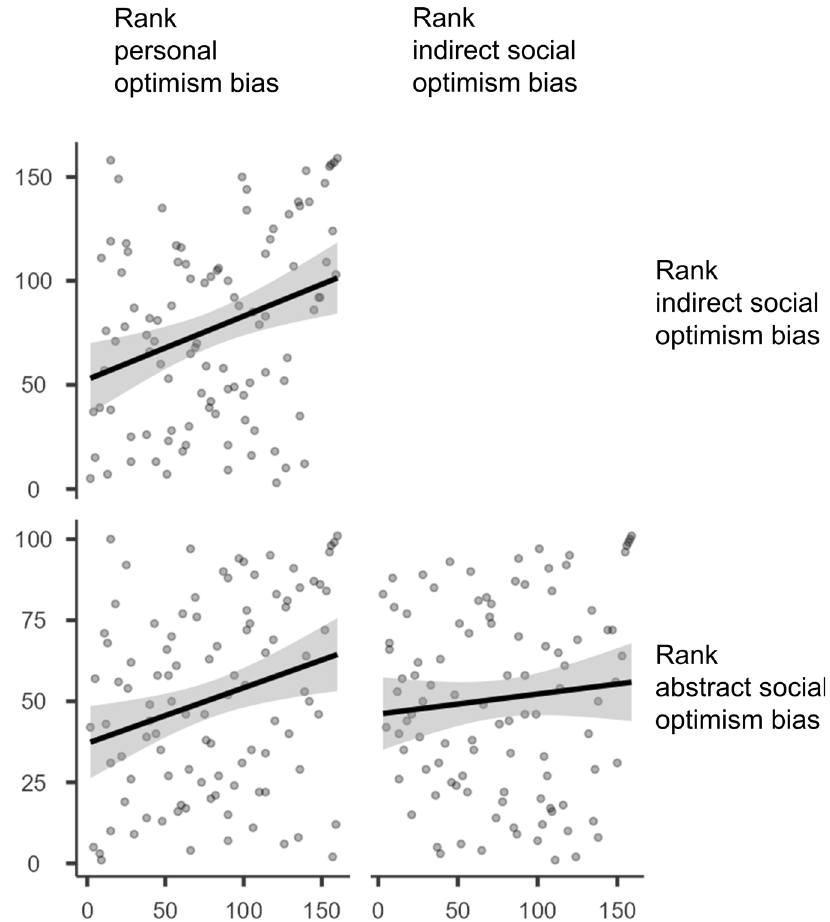
Fig. 3 Spearman correlations between the different forms of personal and social optimism bias. Personal optimism bias is based on the comparison of self vs. rival, indirect social optimism bias on the comparison fi ctitious potential future home team vs. its archrival, and abstract social optimism bias on the comparison fi ctitious favorite international soccer team vs. its